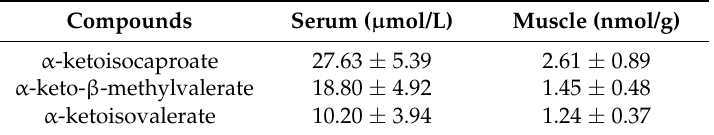
Table 3. Concentration of three BCKAs in animal samples ( n = 6).